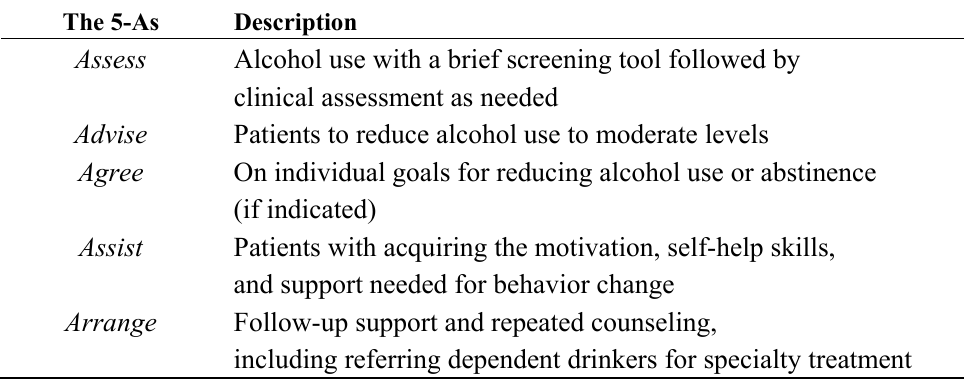
Table 1. The 5-As behavioural counseling framework applied to alcohol